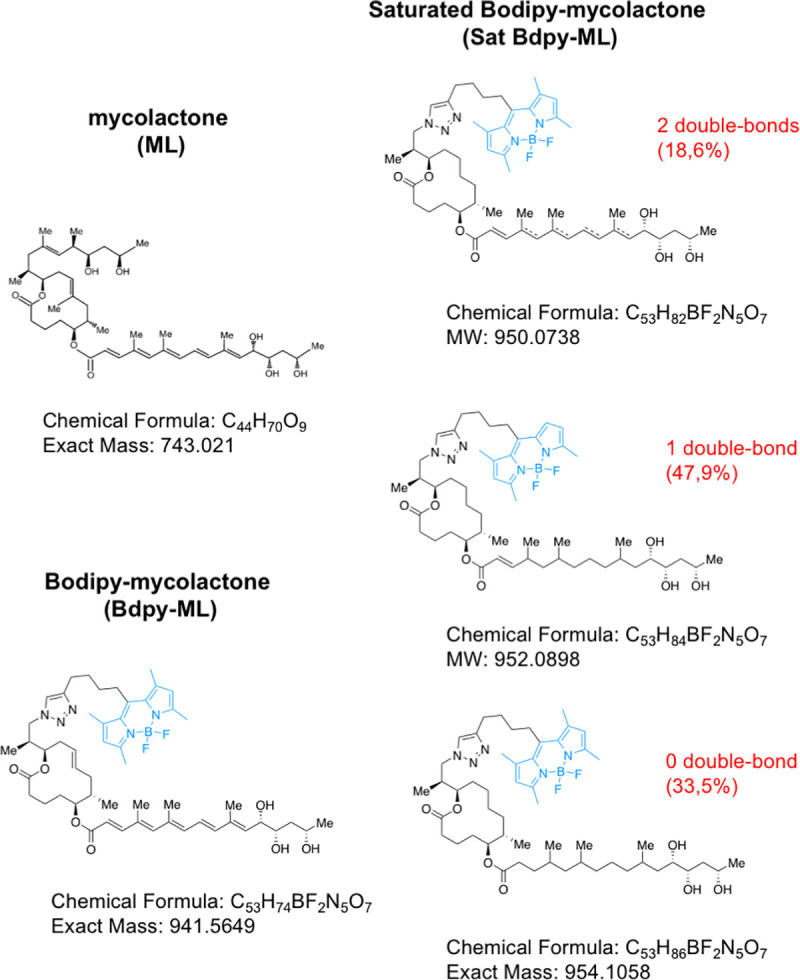
Structures of natural ML and fluorescent derivatives used in this study.Natural ML is constituted of a lactone ring on which are appended two polyketide chains. In Bdpy-ML, the shortest polyketide chain was substituted with a bodipy fluorophore. Saturation of Bdpy-ML’s resulted in Sat-Bdpy-ML, a mixture of compounds presenting two, one or no double bounds within the longest polyketide chain (dotted lines indicate the putative positions of the double bonds).